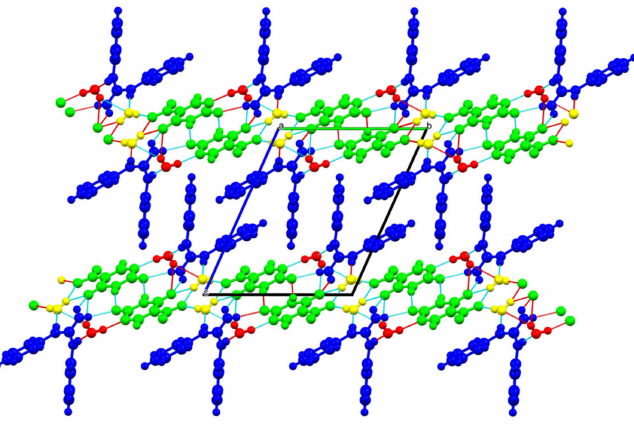
Figure 24. Crystal packing of (XX) viewed along the a axis. 5NU ions are shown in solid green, highlighting the dimer